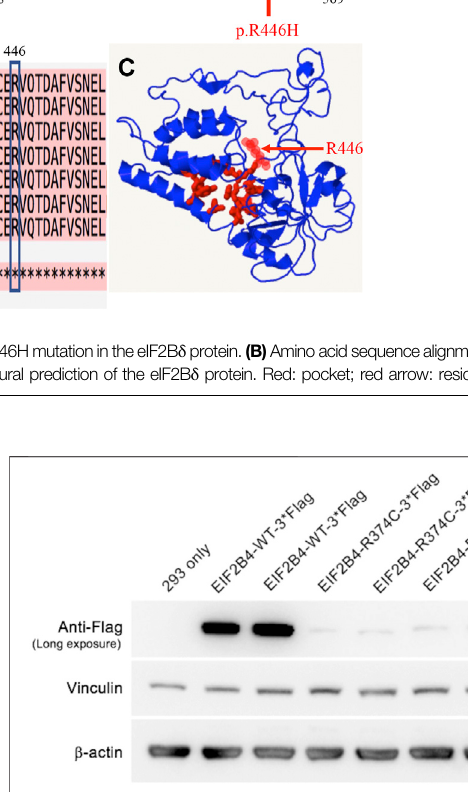
FIGURE 4 | Expression of wild-type and mutant eIF2B δ in transfected HEK 293 cells. The levels of eIF2B δ − R374C and R446H were signi fi cantly reduced compared with the wild-type